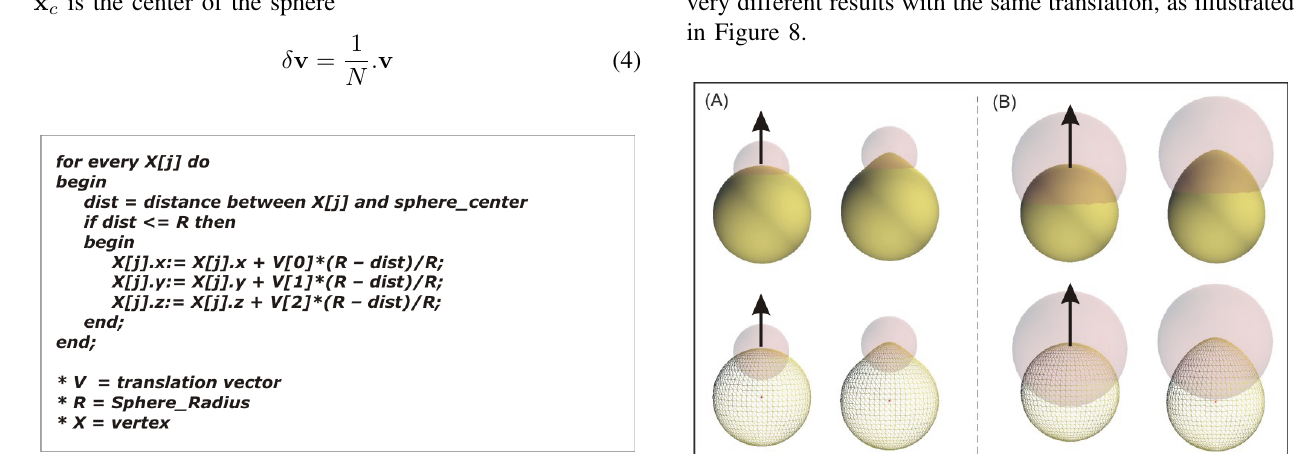
Figure 8. (A) Deformation in the opposite direction of Figure 7. (B) Deformation using influence zone with larger radius.